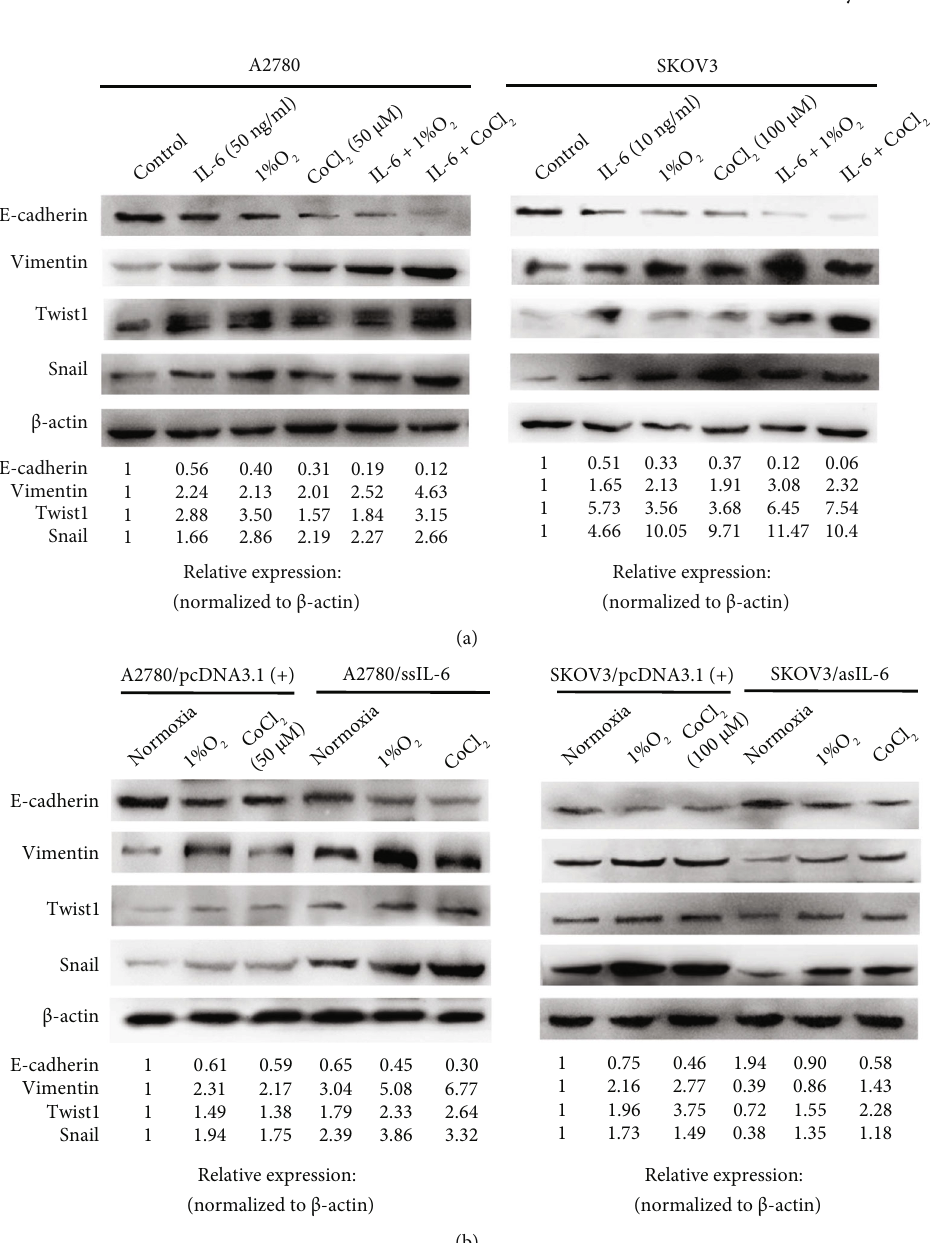
) or hypoxic (1% O or CoCl ) 2 2 2